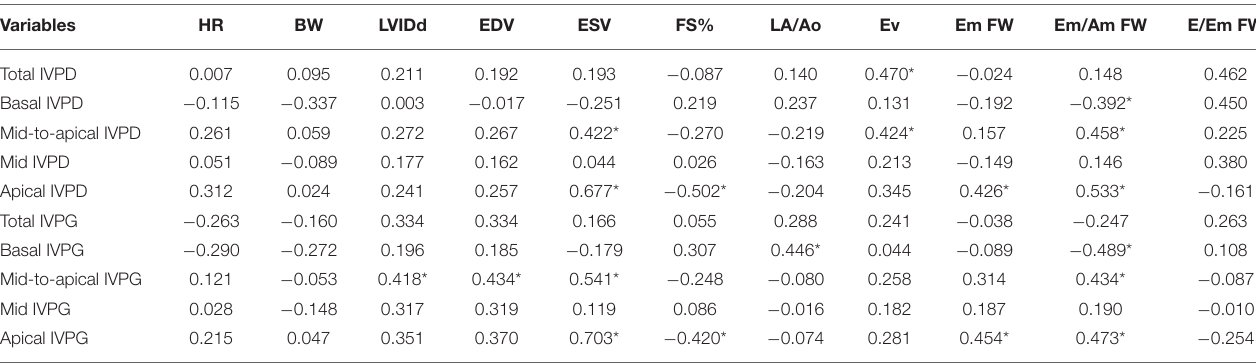
TABLE 3 | Correlation between CMME indices and echocardiographic